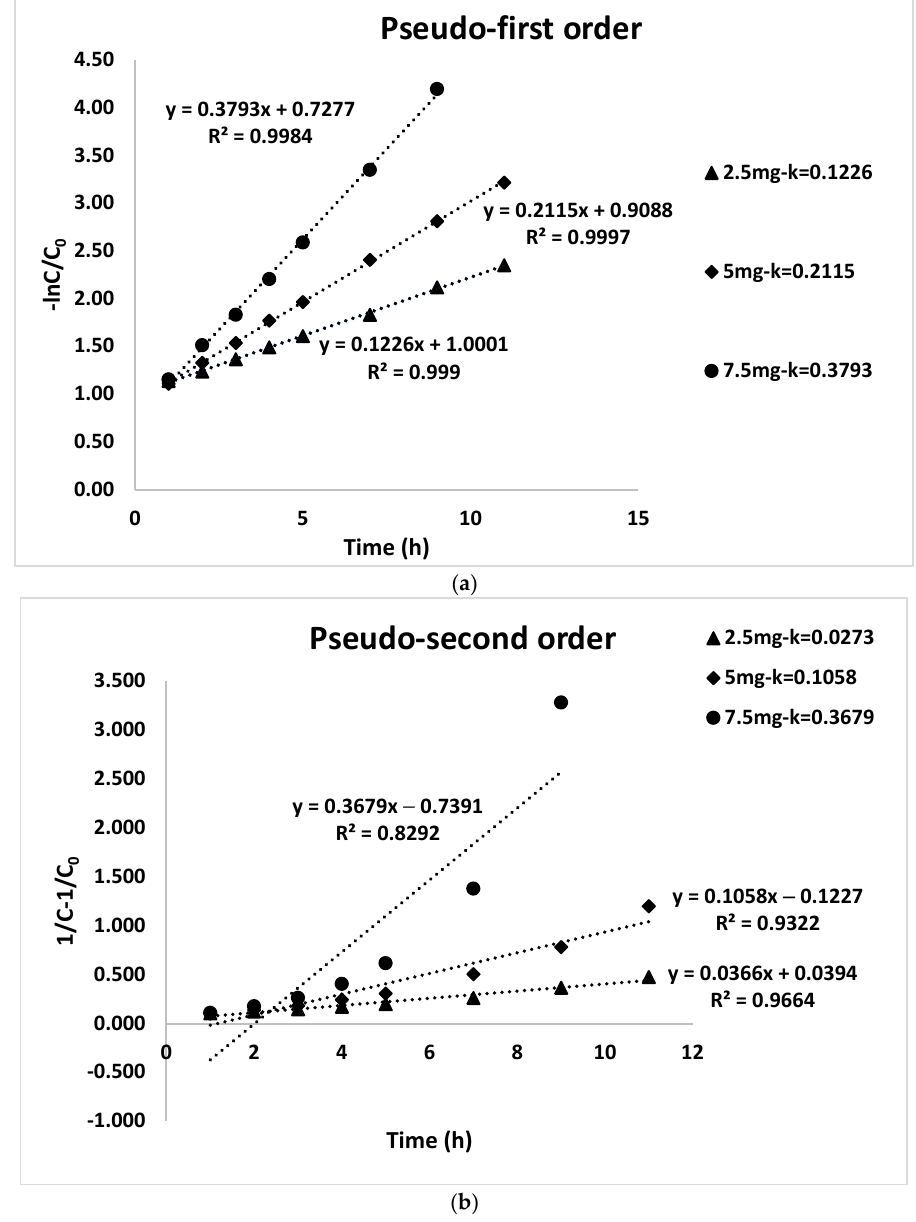
Figure 10. ( a ) Pseudo-first-order kinetic model. ( b ) Pseudo-second-order kinetic model.